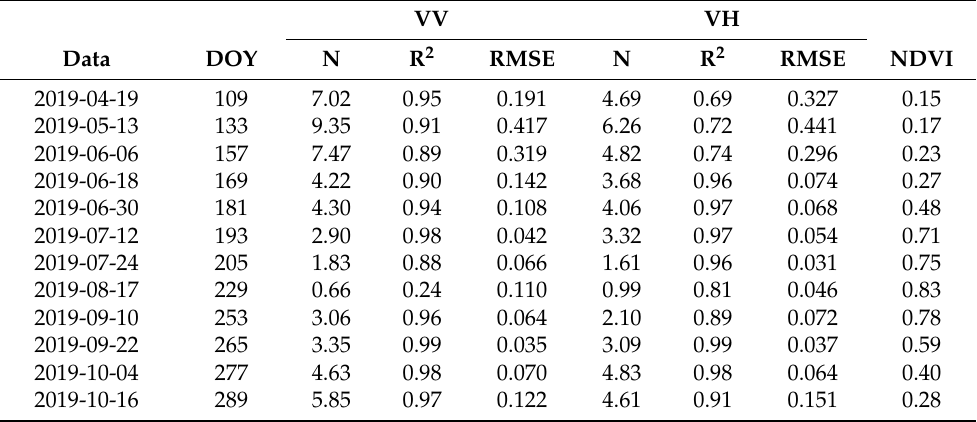
Table 2. The fitted accuracy (R 2 and RMSE) and N value for σ 0 vv and σ 0 the corresponding NDVI value was computed from Sentinel-2 reflectance.